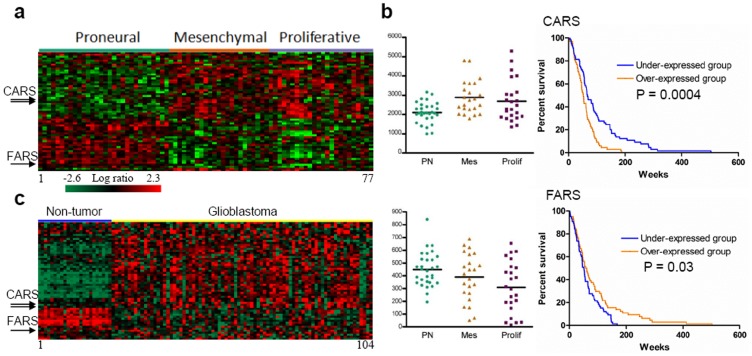
ARSN biology-dominant groups in patients with GBM.(a) We identified probe sets whose expression most strongly correlated with survival (Kaplan-Meier plots versus survival times, log-rank t-test <0.05). This analysis identified that 122 resulting probe sets of ARSN, DTGs, and PPIs that were correlated with survival in patients with GBM. Then, we performed a supervised clustering with the probesets and GBM subtypes such as proneural (PN), proliferative (Prolif) and mesenchymal (Mes). This analysis showed that 61 probeset as signature genes were differentially expressed in the three discrete subgroups. The 61 probe sets are presented in matrix format, where rows represent individual genes and columns represent each tissue. Each cell in the matrix represents the expression level of a gene in an individual tissue. Red and green cells reflect high and low expression levels, respectively. (b) Tumor subgroups are distinguished by CARS and FARS. Horizontal bars denote mean values. CARS is enriched in Mes and Prolif subgroups, while FARS in PN subgroup. Each Kaplan-Meier plot of overall survival in 130 GBM patients grouped on the basis of expression of CARS and FARS. The difference between two groups was significant when the P value was less than 0.05. (c) Hierarchical clustering of the GSE4290 dataset of 81 GBM samples from patients with GBM and 23 non-tumor tissues based on the 61 probe sets. Each gene with an expression status were shown in Supplementary Figure S21–S23. Nine probes were significantly overexpressed in the non-tumor samples, with 2 probes not showing in this analysis.